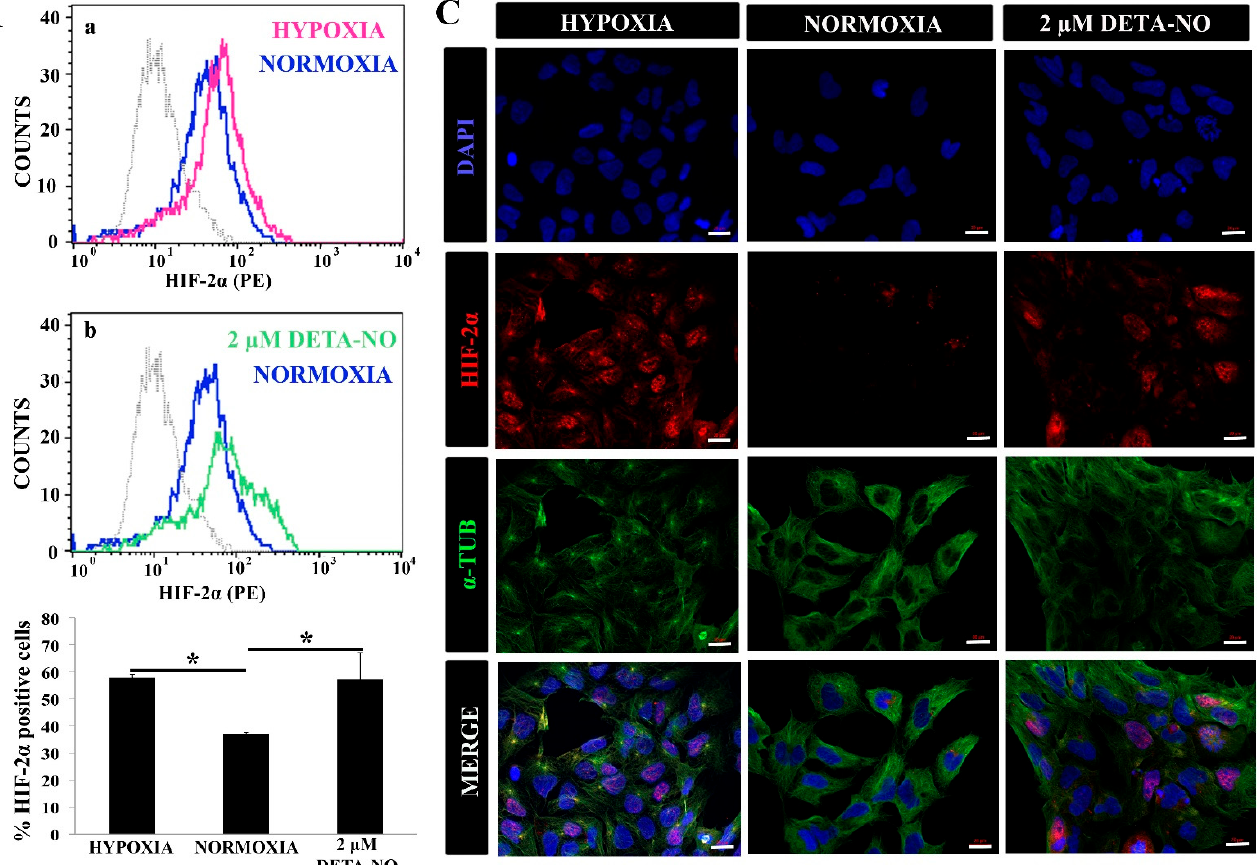
Figure 2. Exposure to 2 µ M DETA-NO induces HIF-2 α accumulation under normoxia. ( A ) Quantification by flow cytometry. Fluorescence intensity for HIF-2 α is plotted against the number of cells. Each plot is representative of three independent experiments. Isotype (IgG) and secondary antibody (PE) shown in gray were used as negative controls. In the study, 5000 cells were analyzed in each experimental condition. a) Representative cytometry plot of cells cultured under hypoxia condition versus normoxia. b) Representative cytometry plot of cells treated with low NO in normoxia condition versus normoxia without NO. ( B ) Percentage of HIF-2 α ± SEM-positive cells from three independent experiments is shown. (*) p < 0.05. ( C ) Exposure to low doses of DETA-NO induces nuclear accumulation of HIF-2 α in normoxia. In the figure, the human induced PS cell line from the MSUH-001 line was observed after 6 days of culture and treatment of 48 h of hypoxia (5% of O 2 ) and 48 h of exposure to DETA-NO 2 µM under normoxia conditions. Cells were labeled with DAPI (blue), anti-HIF-2 α (red), and anti- α -Tubulin (green). Scale bar: 25 µm. The images shown are representative of two inde- pendent experiments and were acquired with the Zeiss ApoTome fluorescence microscope.